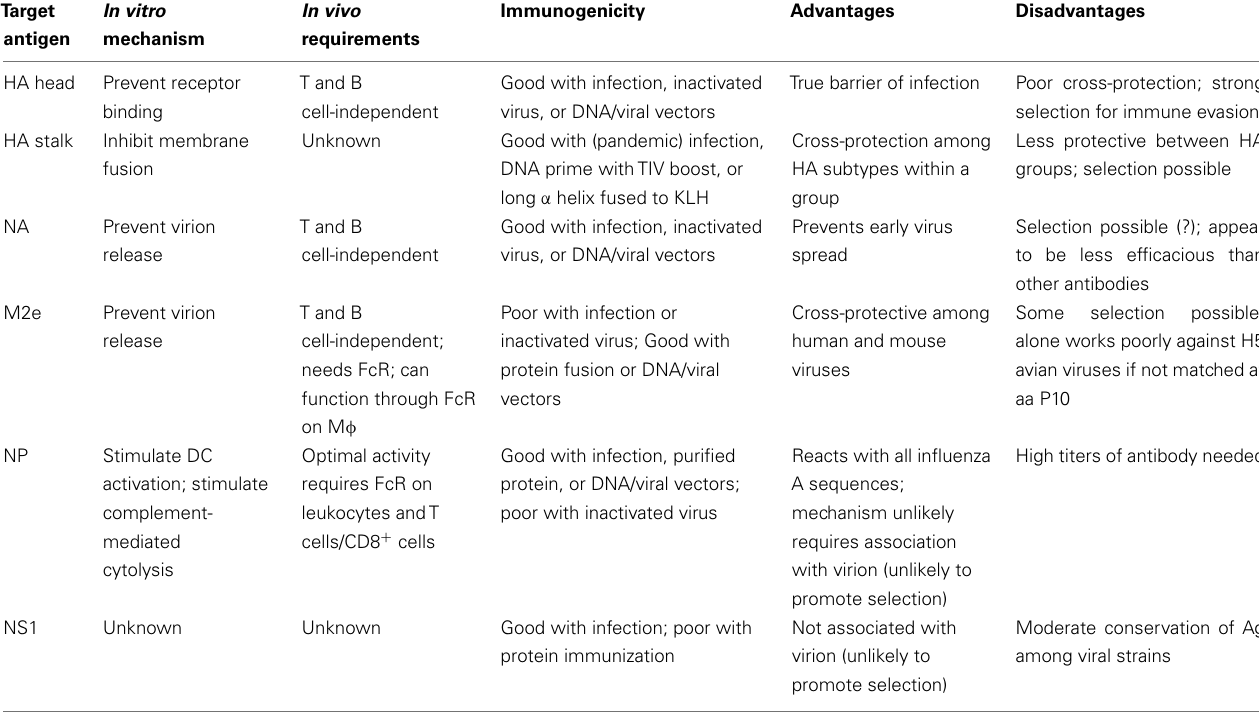
Table 2 | Comparison of antiviral antibodies showing efficacy against influenza virus.